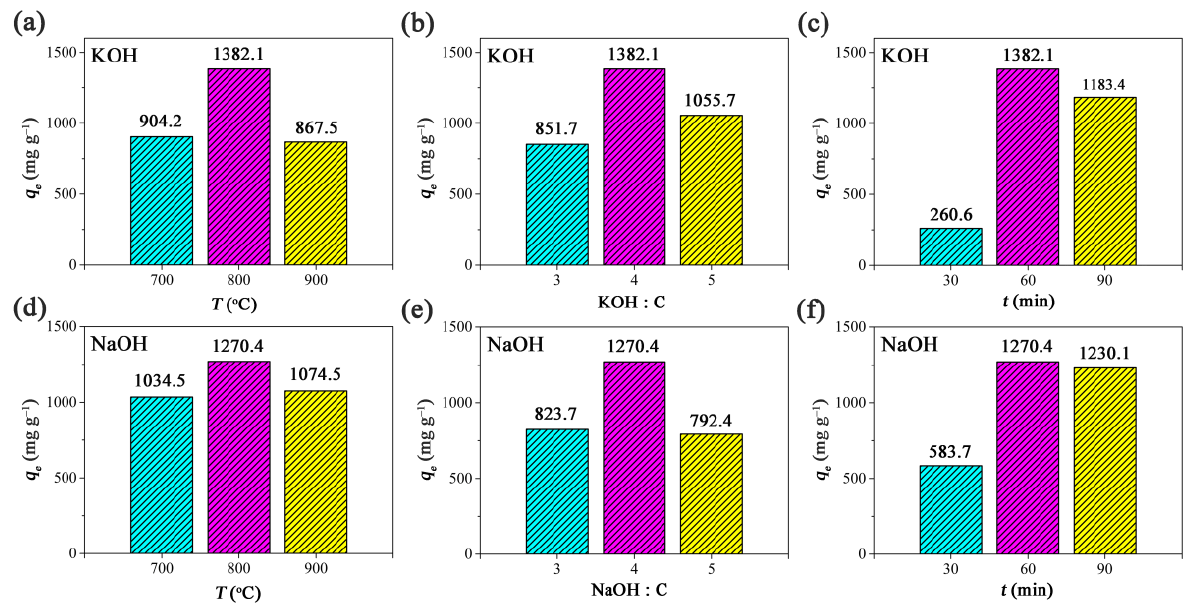
Figure 1. The relationship between the RhB adsorption capacities of porous carbon products and the activation conditions with ( a – c ) KOH and ( d – f ) NaOH used as the activators, respectively. Conditions: adsorbent, 20 mg; solution volume, 200 mL; initial concentration, 400 mg L − 1 ; temperature, 30 °C. The pH values of RhB solutions were not adjusted.